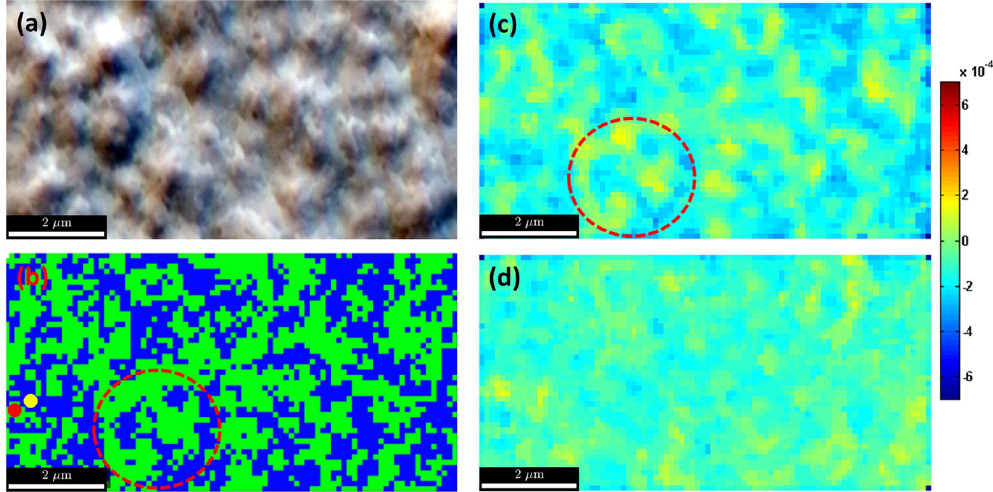
Figure 6. Comparison of IPF maps with cross correlation based MAE maps. ( a ) Forescatter image, ( b ) IPF map, (c ) MAE (in radians) map plotted with green area in the IPF as a reference pattern, see red dot and ( d )) MAE map with blue area as the reference pattern, see yellow